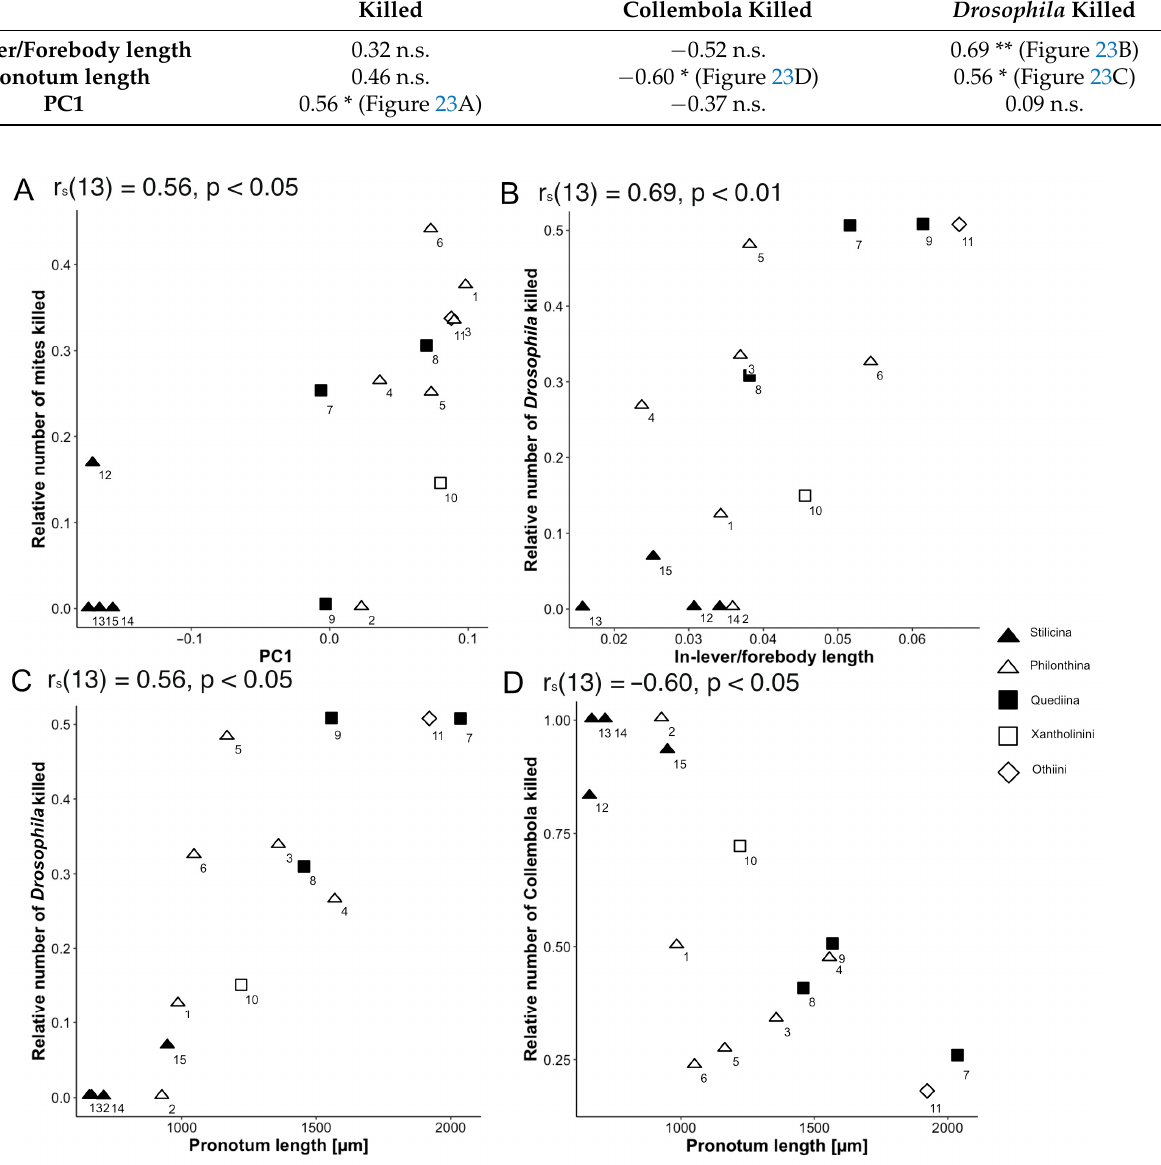
Figure 23. Plots of untransformed original data with Spearman correlations (r s ) for PIC-transformed variables. Relationships between ( A ): PC1 and the relative number of mites killed, ( B ): In-lever/forebody length and the relative number of Drosophila killed, ( C ): pronotum length ( µ m) and the relative number of Drosophila killed, ( D ): pronotum length ( µ m) and the relative number of Collembola killed. Numbers correspond to species abbreviations in Table 1. Table 4. Spearman correlation matrix of variables analysed with phylogenetic independent contrast. Only variables with significant correlations are shown (significance levels: ** p < 0.01, * p < 0.05, n.s. not significant), sample size N = 14.